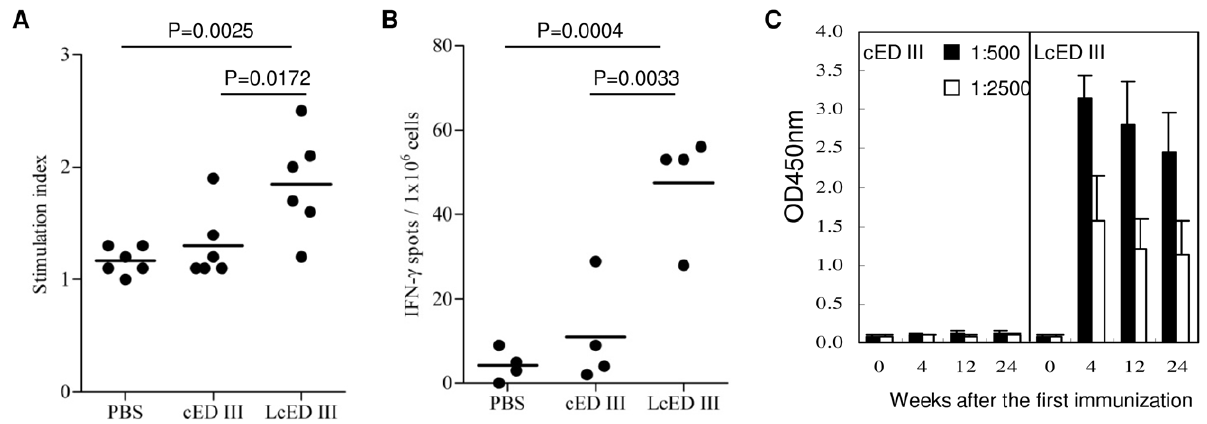
Figure 2. LcED III augments cellular and humoral immune responses. BALB/c mice were immunized subcutaneously with 20 m g of cED III or LcED III two times at a two-week interval. (A) Seven days after the last immunization, splenocytes were incubated with or without cED III (10 m g/mL). The stimulation index (SI) is defined as the ratio of the mean counts per minute (cpm) with cED III stimulation to the mean cpm without antigen stimulation. Results were pooled from two independent experiments. P values were calculated using an unpaired one-tailed Student’s t -test. (B) The frequencies of IFN- c -secreting cells in spleens were evaluated by mouse IFN- c ELISPOT kits. Results are representative of two independent experiments. P values were calculated using the unpaired one-tailed Student’s t -test. (C) Sera were collected at the indicated time points after the first immunization. Serum samples were diluted 1:500 and 1:2500 in PBS. Antibody responses against cED III were evaluated by ELISA. Pre-immune sera (week 0) were collected and used as basal levels. Results are plotted as the mean of optical density values plus standard deviation (n=5).